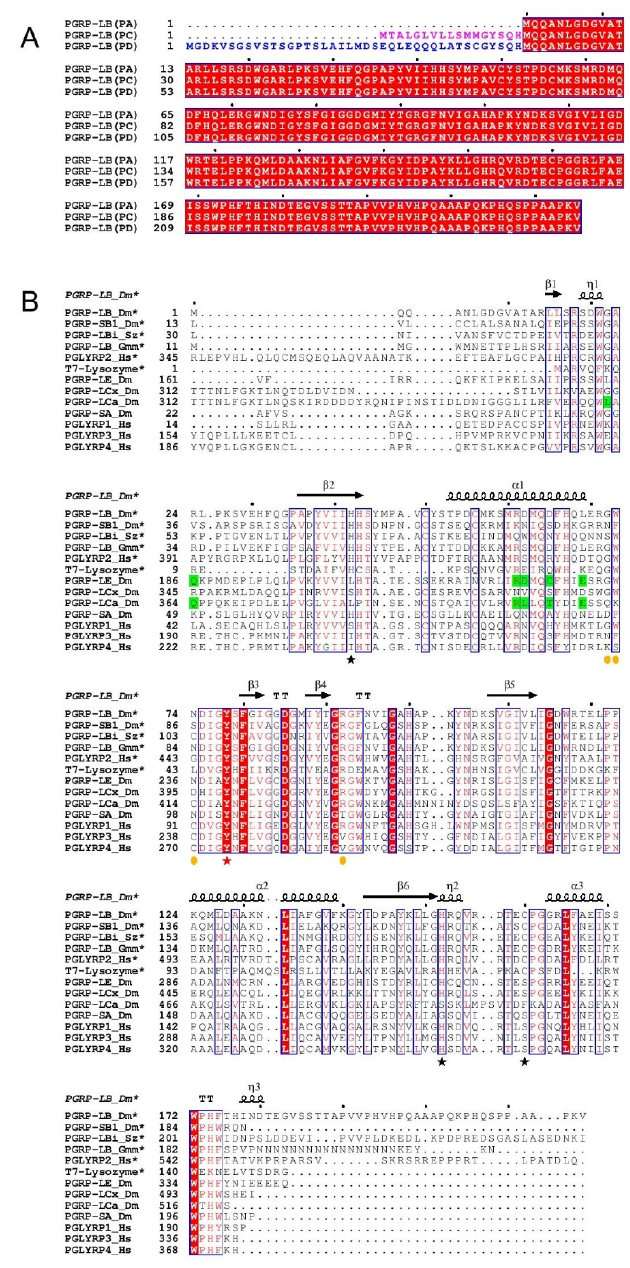
Figure 1. ( A ) Multiple sequence alignment of different isoforms of Drosophila melanogaster PGRP-LB. The signal peptide of PGRP-LB PC is highlighted in pink while the N-terminal part of PGRP-LB PD with no homology is highlighted in blue. The fully conserved residues are framed and highlighted in red. ( B ) Multiple sequence alignment of catalytic and non-catalytic PGRPs. The residues indicated by black stars are responsible for the Zn 2+ interaction in Drosophila PGRP-LB (H42, H152 and C160), the residue indicated by red star makes a fourth coordination with Zn 2+ through a water molecule in Drosophila PGRP-LB (Y78). Orange circles indicate the residues responsible for the DAP/Lys specificity. Residues highlighted in green indicate residues responsible for the interaction with the sugar moiety of TCT at the dimer interface in complexed structure PGRP-LC and PGRP-LE. The conserved residues are framed and highlighted in red (fully conserved) or written in red (partially conserved). Only the Drosophila PGRP-LB PA/PC isoform is represented in this alignment. Dm = Drosophila melanogaster , Hs = Homo sapiens , Sz = Sitophilus zeamais and Gmm = Glossina morsitans morsitans . * for the catalytic proteins. Figures were made using ESPript3.0